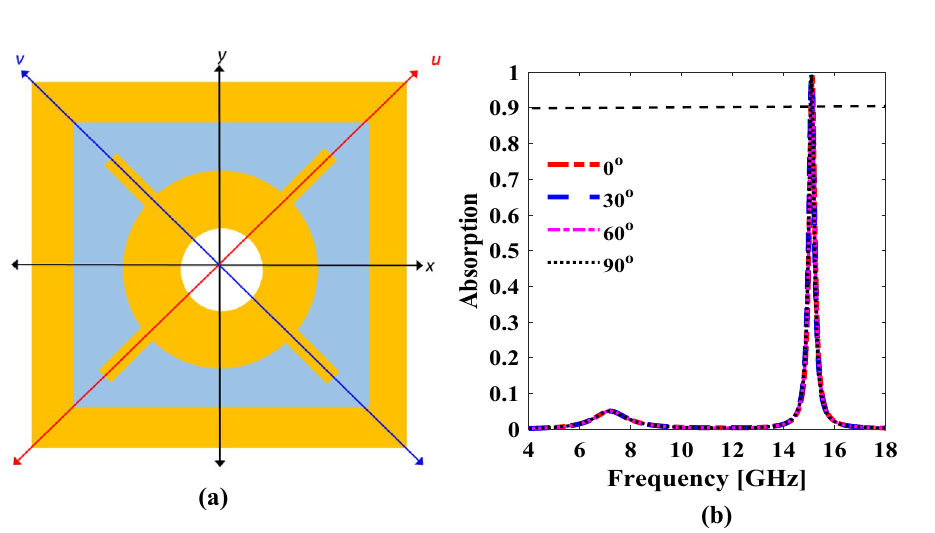
Figure 10. ( a ) 90º rotated symmetry (C4) and mirror symmetry along u-, v-, x- and y-axes ( b ) Metasurface response when electric field polarization is rotated from 0° to 90°. *The figure is created using MATLAB ver. R2020A-URL: https:// www. mathw orks. com/ produ cts/ matlab.